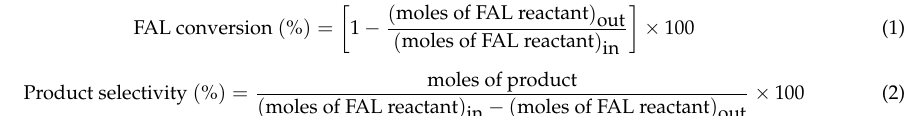
Figure S4: FTIR of reduced catalysts, Figure S5: NH 3 -TPD of Ni 5 Cu 15 /m-SiO 2 and Ni 5 Cu 15 /C-SiO 2 , Figure S6: BET of silica after metal loading on silica. (a) m-SiO 2 , (b) Ni 20 /m-SiO 2 , (c) Ni 15 Cu 5 /mSiO 2 , (d) Ni 10 Cu 10 /m-SiO 2 , (e) Ni 5 Cu 15 /m-SiO 2 , and (f) Cu 20 /m-SiO 2 , Figure S7: Catalytic performance in furfural (FAL) hydrogenation over metals supported on m-SiO 2 . Reaction condition: 5.2 mmol FAL, 15 mL water, catalyst 0.05 g, 140 ◦ C, 3 MPa H 2 , and 4 h, Figure S8: Rearrangement of